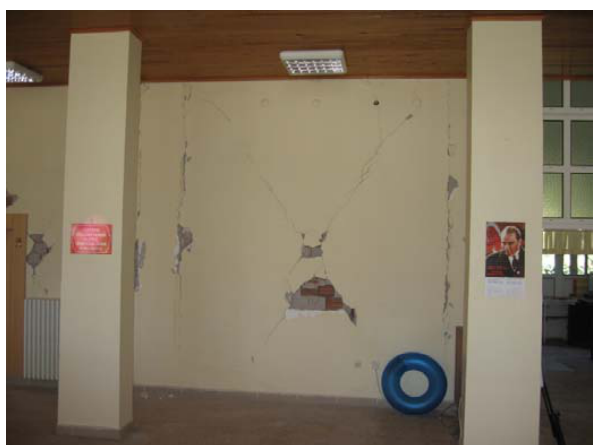
design of column, beam, and shear wall elements. The TBC includes requirements for the design and detailing of RC components but does not include ductile detailing require- ments for use in seismic